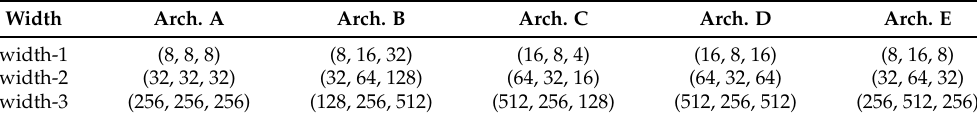
Table 1. Different combinations of number of nodes used in three hidden layers of the five network Architecture shapes A–E (Arch. A–E) presented in in Figure 1. Width of each model architecture shape was varied by changing the number of nodes per layer. For each model architecture, the number of nodes used is shown as, ( n 1 , n 2 , n 3 ) and they represent the number of nodes in first, second and third hidden layers, respectively. Width Arch. A Arch. B Arch. C Arch. D Arch.